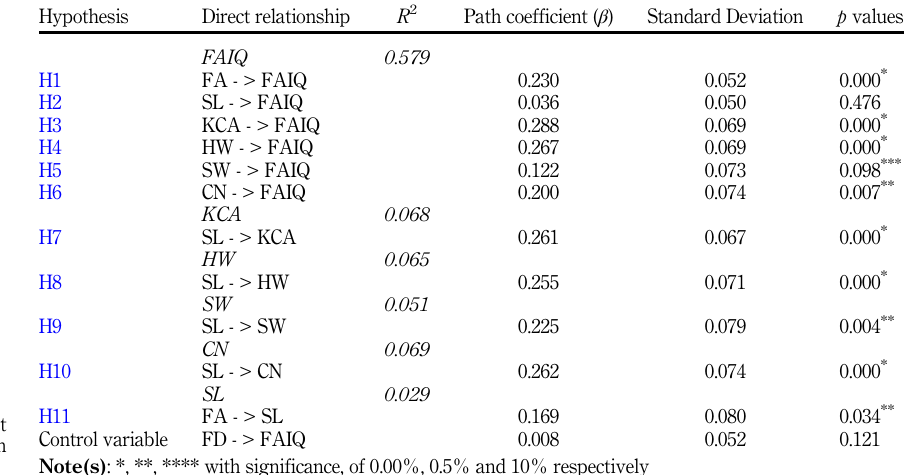
Table 3. Test results of direct relationship between the